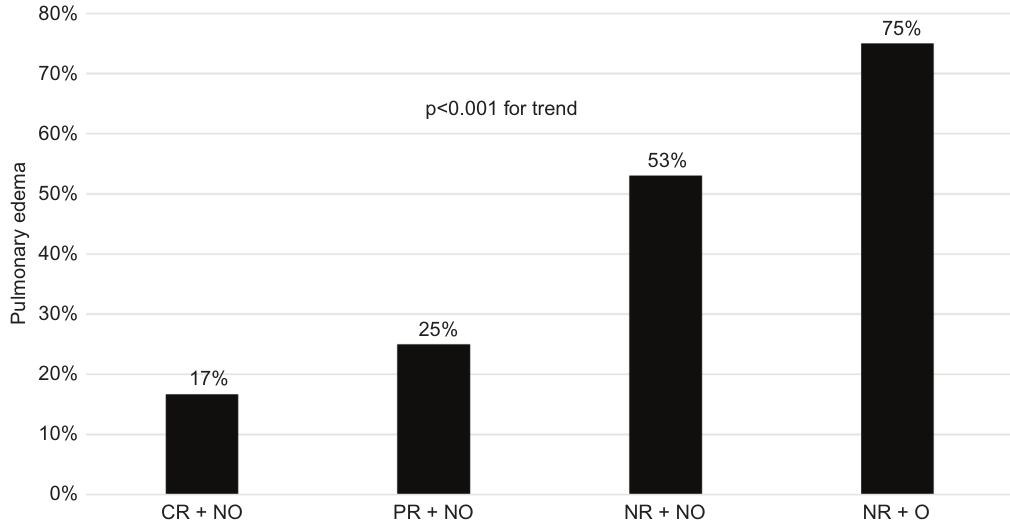
Figure 1. Risk of new onset pulmonary edema strati fi ed by renal recovery status and oliguria in 93 patients with hepatorenal dis- orders receiving intravenous albumin. CR, complete recovery; NO, nonoliguric; NR, no recovery; O, oliguric; PR, partial